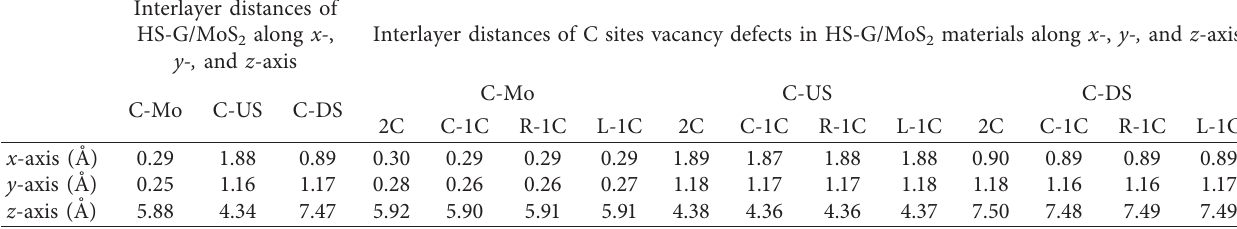
2 and (ii) C sites vacancy defects in HS-G/MoS 2 materials.